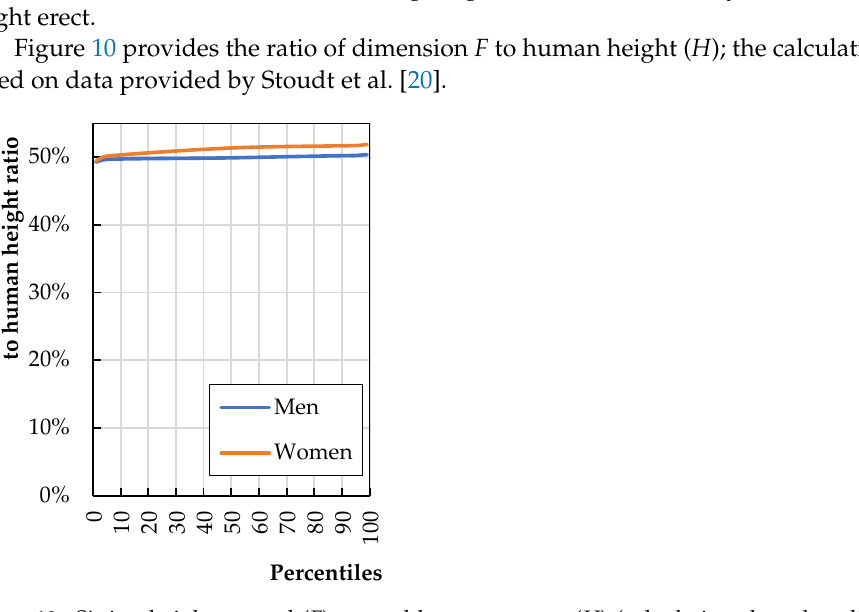
Figure 10. Sitting height normal ( F ) to total human stature ( H ) (calculations based on literature data [20]).